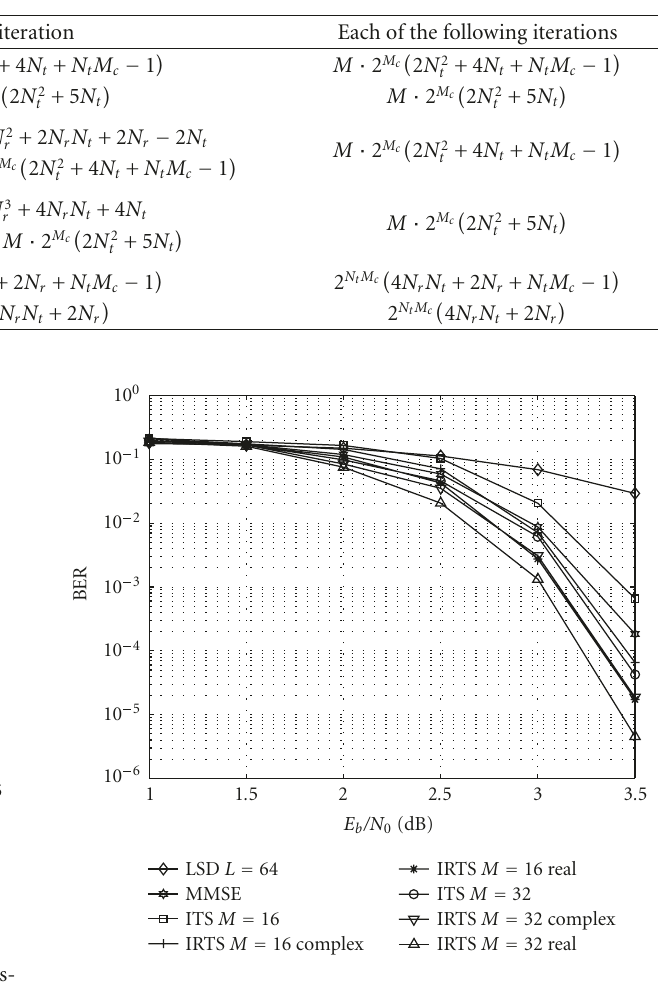
Table 2: Operation counts for ITS, IRTS, and exact MAP detection, per symbol period ( N t M c bits).